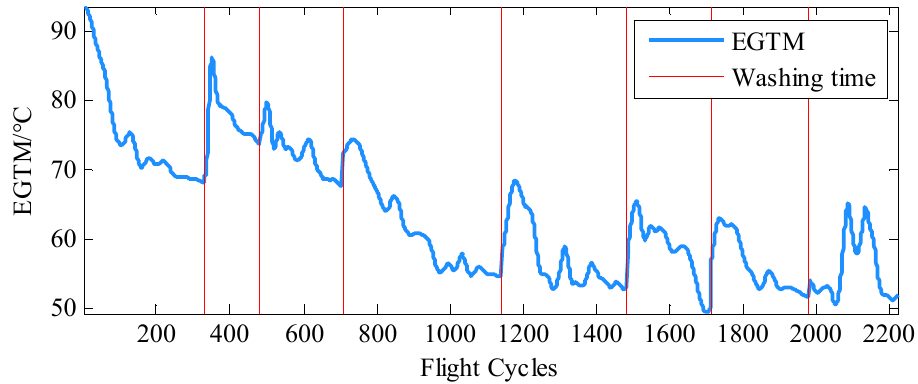
Figure 8. The engine data involved in this paper.